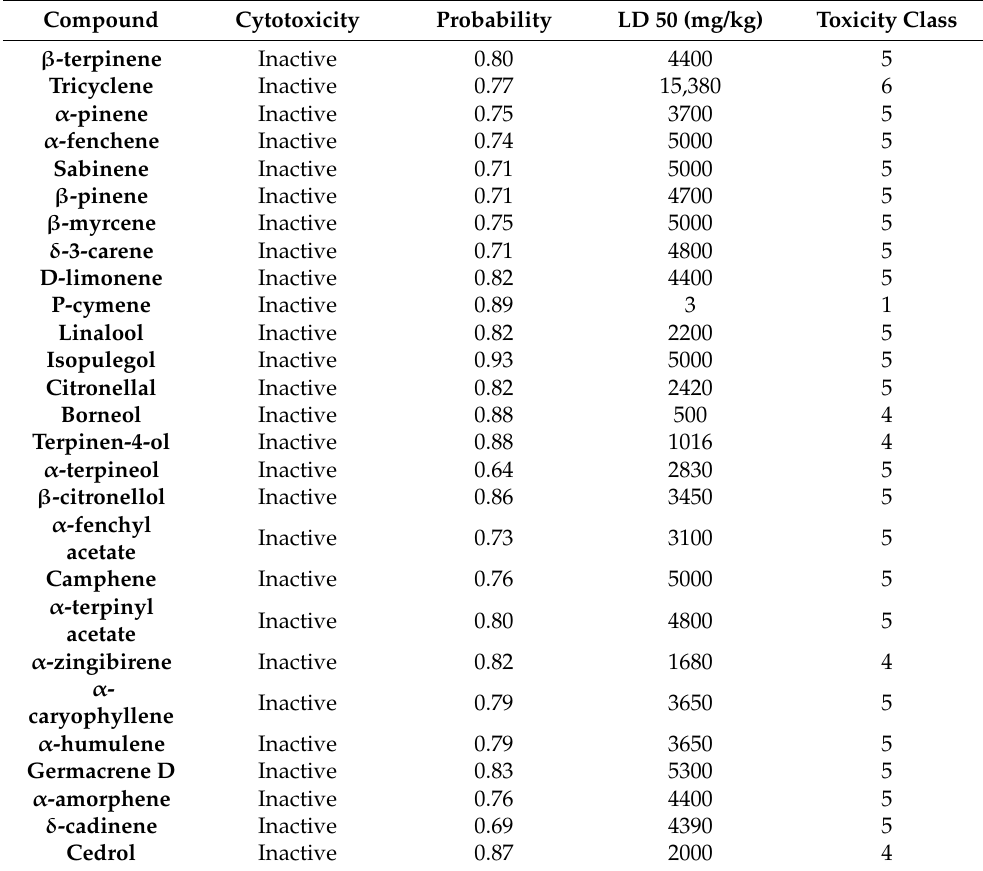
Table 5. Rodent oral toxicity and cytotoxicity of (CSEO) compounds, food preservatives, and efflux pumps inhibitors (EPI) predicted by the PROTOX II